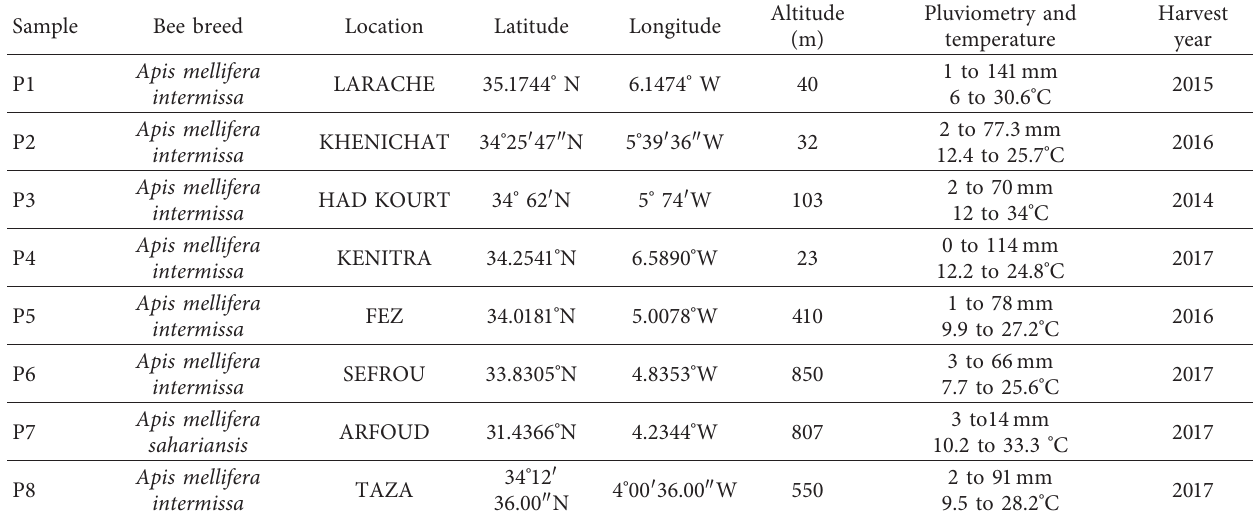
Table 1: Geographical location, bee breed, and harvesting period of bee pollen samples.